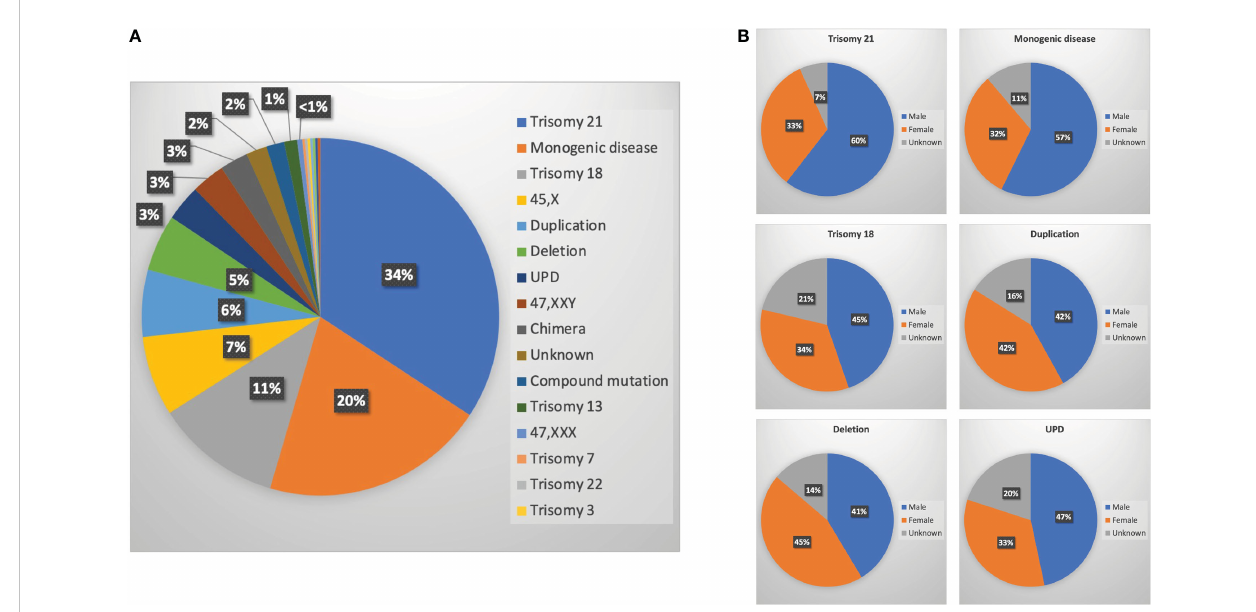
FIGURE 3 Genetic testing for malformed fetuses. (A) Ratio of different genetic abnormalities; (B) sex ratio of six main genetic abnormalities [trisomy 21, monogenic diseases, trisomy 18, duplications, deletions, and uniparental disomy